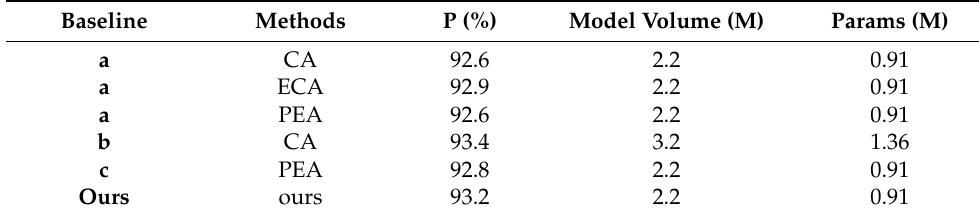
Table 9. The ablation study of CA on the SSDD dataset.